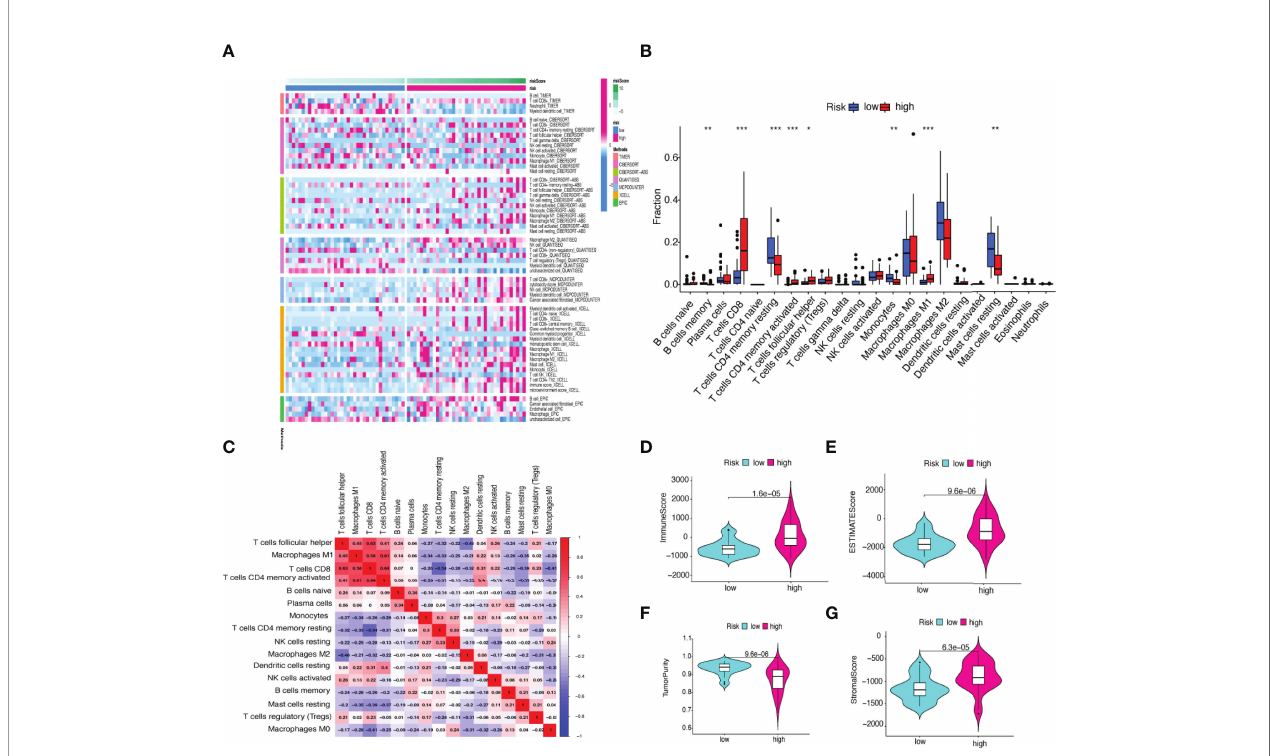
FIGURE 9 | (A) Heatmap of immune cell expression using a variety of algorithms. (B) The proportion of each typical immune cell between the two groups. (C) The correlation of immune cells shown in a heatmap. (D – G) Comparison of the (D) immune, (E) ESTIMATE, (F) tumor purity, and (G) stromal score. * p < 0.05, ** p < 0.01, and *** p <